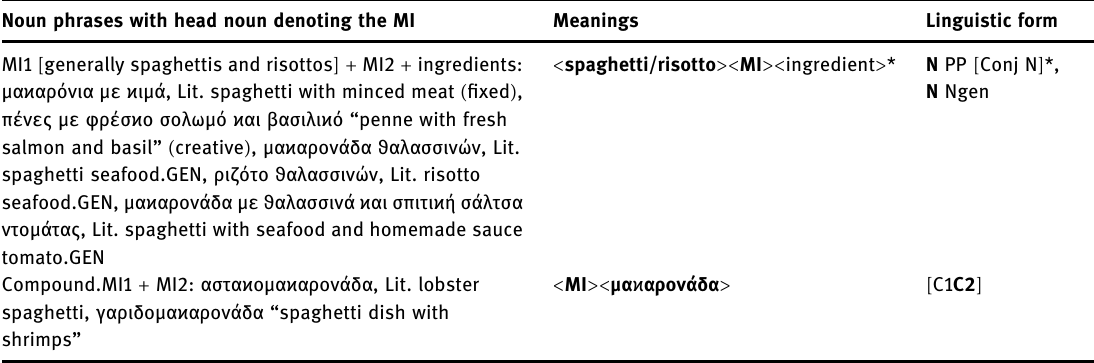
Table 2: Dish names headed by a noun denoting pasta or rice with modi fi ers denoting a second MI Noun phrases with head noun denoting the MI Meanings Linguistic